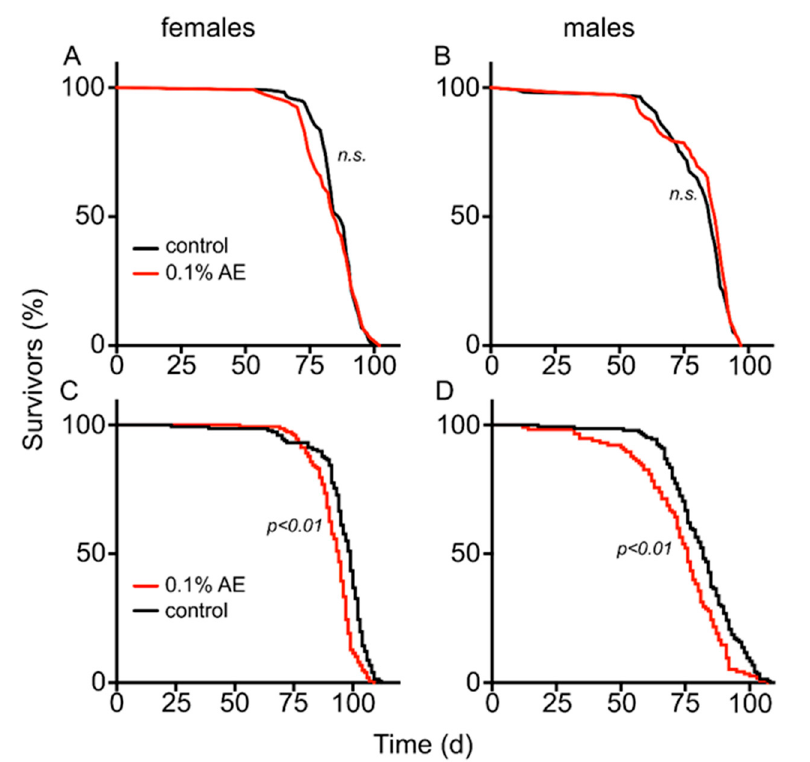
Figure 5. Effect of BAE on lifespan in TOR-deficient animals. TOR-deficient females ( A ) and males ( B ) were analyzed with regards to their lifespans. Control food (black lines) and those subjected to control food plus 0.1% BAE were analyzed. Effect of algae extract (AE) on lifespan in animals with overexpression of a dominant negative isoform of TOR ( C , D ) specifically targeted to the fat body, using the hormone-inducible GeneSwitch system in females ( C ) and males ( D ). Experimental animals induced by addition of the hormone only hold on normal food (black lines) and those subjected to 0.1% AE are shown. n > 100 for each experiment. p -values are given in the figures.